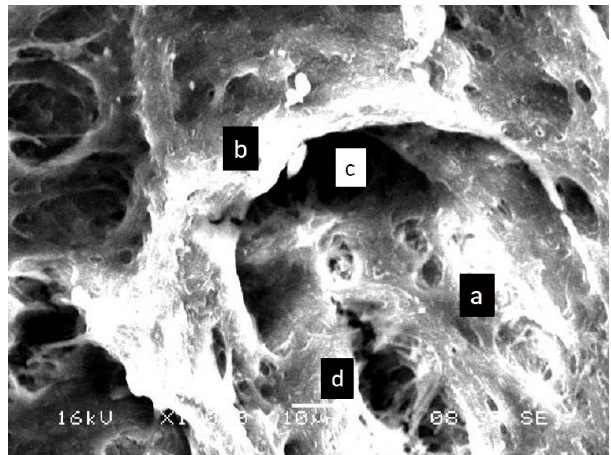
Figure 3. SEM image of the labial surface of primary tooth showing loosely packed enamel rod and inter-rod: ( a ) enamel rod; ( b ) inter-rod enamel; ( c ) rod sheath space; ( d ) perforations along the rod.